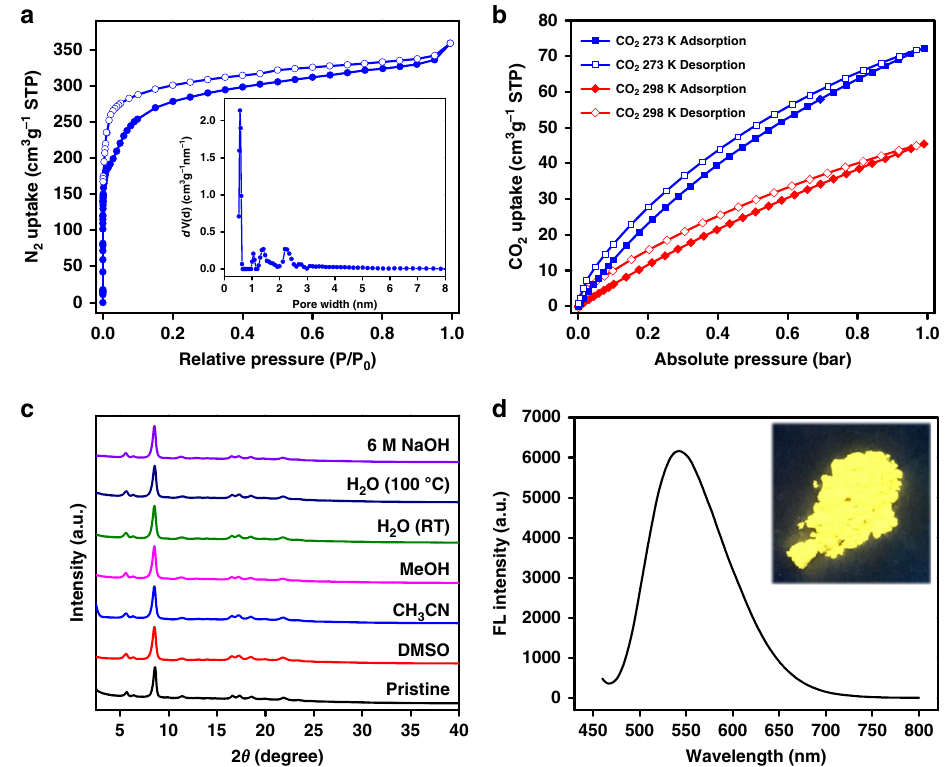
Fig. 4 Characterization of 3D-TPE-COF. a N 2 adsorption and desorption isotherms of 3D-TPE-COF at 77 K. The inset is the pore size distribution of 3D- TPE-COF calculated from the quenched solid density functional theory; b CO 2 adsorption and desorption isotherms of 3D-TPE-COF at 273 K and 298 K; c PXRD patterns of 3D-TPE-COF after treatment in different solvents for 24 h; d solid-state fl uorescence spectrum of 3D-TPE-COF ( λ ex = 450 nm). The inset is the photograph of 3D-TPE-COF powders under UV light